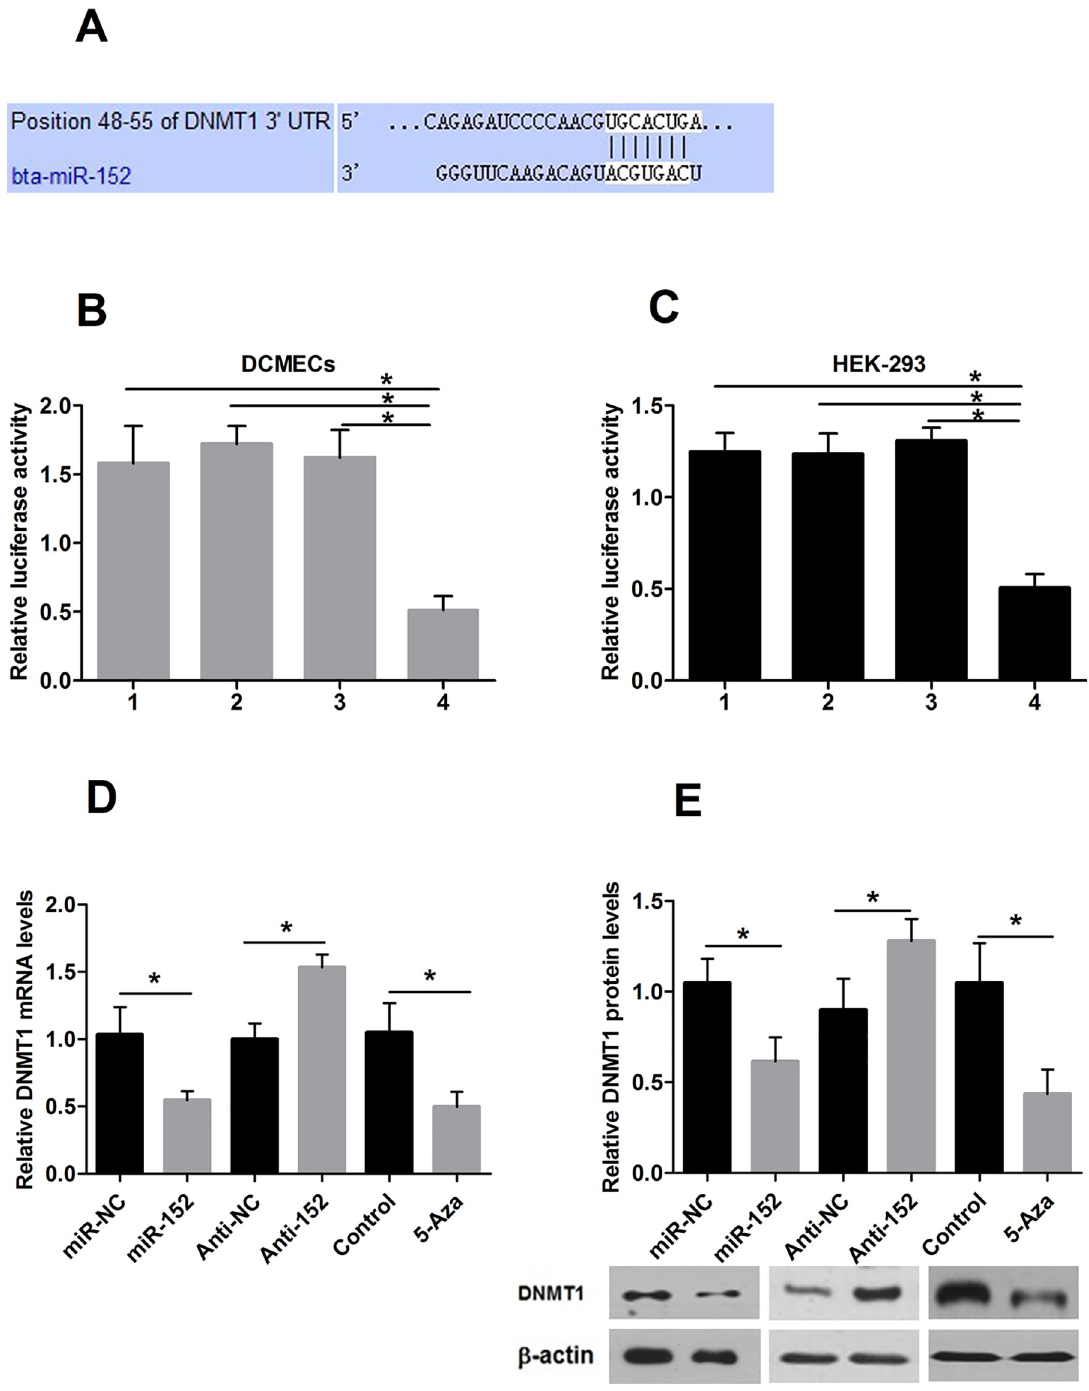
Fig 3. miR-152 regulates DNMT1 expression by binding its 3 0 UTR. A: miR-152 binds to the 3 0 UTR of DNMT1 in position 48–55. B, C: DNMT1 3 0 UTR was inserted downstream of the luciferase pMIR-reporter vector. Luciferase activity was measured in DCMECs and HEK-293 cells. 1 phRL-TK and empty pMIR-REPORT vector cotransfection; 2 miR-152, phRL-TK, empty pMIR-REPORT vector cotransfection; 3 miR-NC, phRL-TK, DNMT1-pMIR-REPORT vector cotransfection and 4 miR-152, phRL-TK, DNMT1-pMIR-REPORT vector cotransfection. Luciferase activities of DNMT1-pMIR-REPORT are markedly decreased in cells transfected with miR-152 compared to those of reporter plasmids with miR-NC or empty vectors. D: Dnmt1 mRNA expression after treatment with miR-152, Anti-152, 5-Aza or their respective controls in DCMECs. E: DNMT1 protein expression of DCMECs treated with miR-152, Anti-152, 5-Aza or their respective controls. MiR-152 targets DNMT1 and represses the expression of DNMT1 mRNA